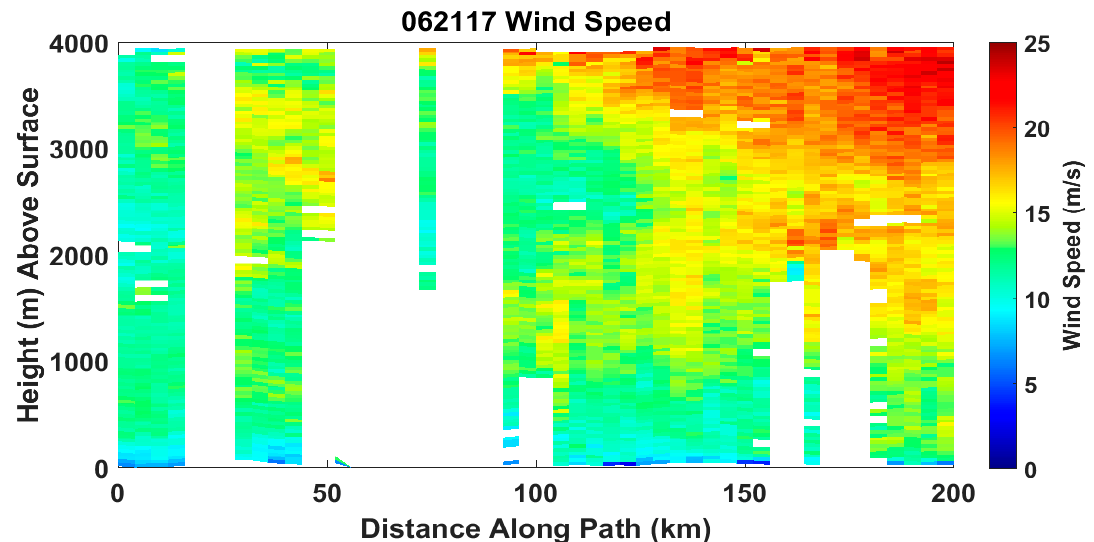
Figure 20. DAWN vertical profiles of SNR ( a ), wind speed ( b ) and wind direction ( c ) NW of the center of TS Cindy at 203740Z on 21 June 2017.